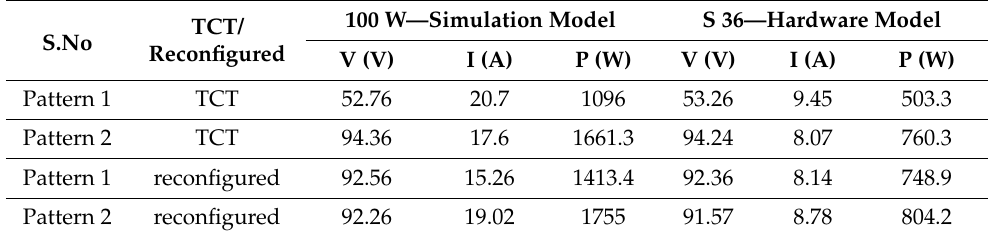
Table 4. Parameters of PSO, P&O, and the two-phase P&O method. PSO Two Phase P&O C 1 =